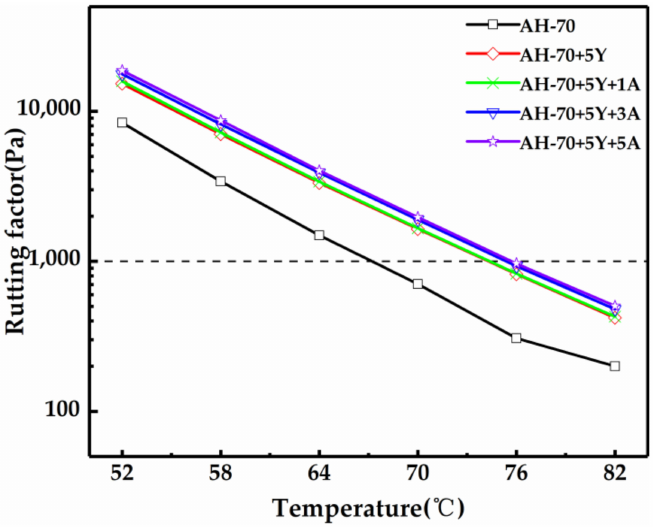
Figure 2. Rutting factor of A-Pal-compounded SBS-modified asphalt.